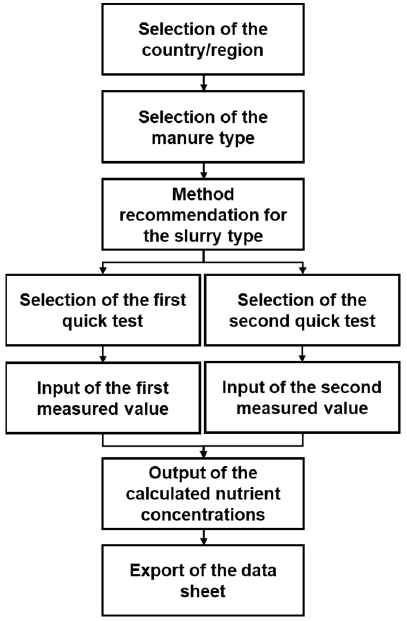
Figure 2. Flow chart for the mobile device application.